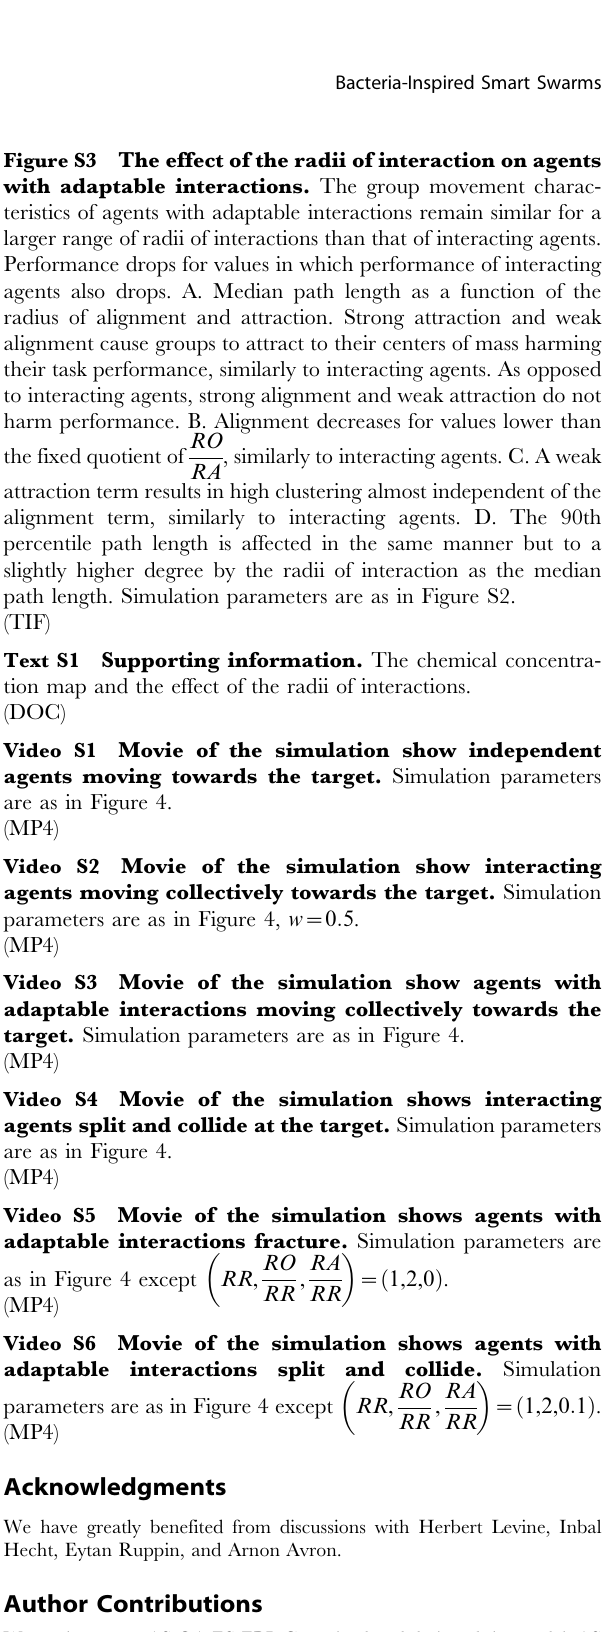
Figure S2 The effect of the radii of interaction on Video S5 Movie of the simulation shows agents with interacting agents. The radii of interaction control all adaptable interactions fracture. Simulation parameters are characteristics of the group’s behavior, pattern and performance. A. Median path length as a function of the radius of alignment and attraction. Strong attraction and weak alignment cause groups to attract to their centers of mass and stay in place, harming their task Video S6 Movie of the simulation shows agents with performance. Strong alignment and weak attraction cause adaptable interactions split and collide. Simulation excessively high conformity in the group which again, harms RO performance. Intermediate values around a fixed quotient of RA reach optimal performance. B. Alignment decreases for values RO . C. A weak attraction term lower than the fixed quotient of RA results in high clustering by the end of the simulation almost independent of the alignment term. D. The 90th percentile path length is affected in the same manner but to a higher degree by the radii of interaction as the median path length. Simulation parameters are as in Figure 8, apart from RO , RA .